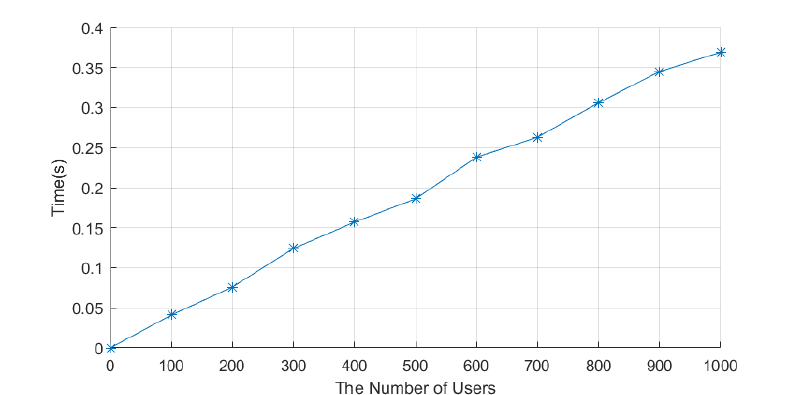
Figure 5. Time to encrypt data in the proposed protocol.